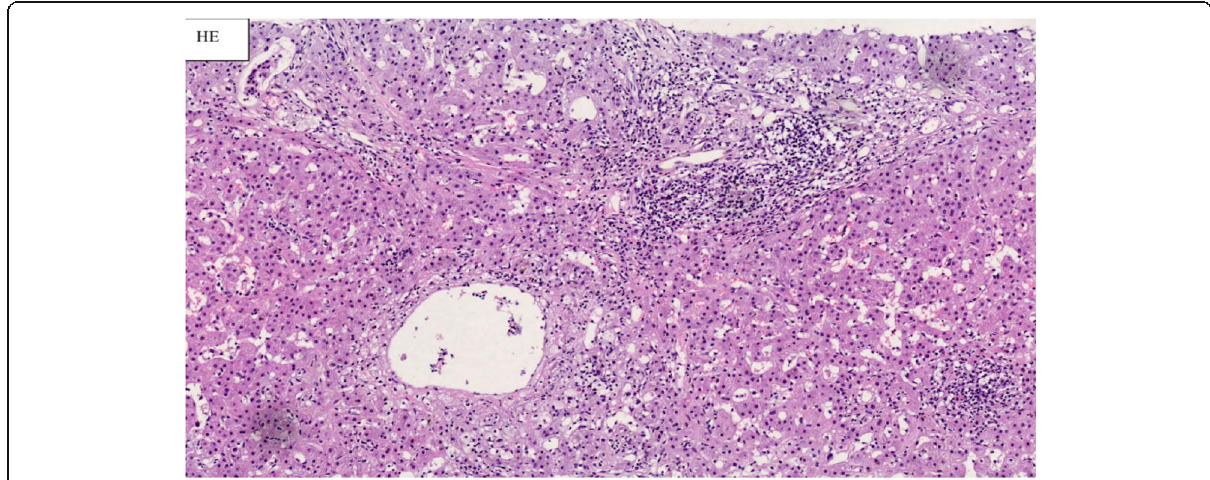
Fig. 2 Hepatic tissue of Hematoxylin and eosin staining. Hematoxylin and eosin staining showed 25 fibrosis expanded small and medium portal areas and an incomplete large one